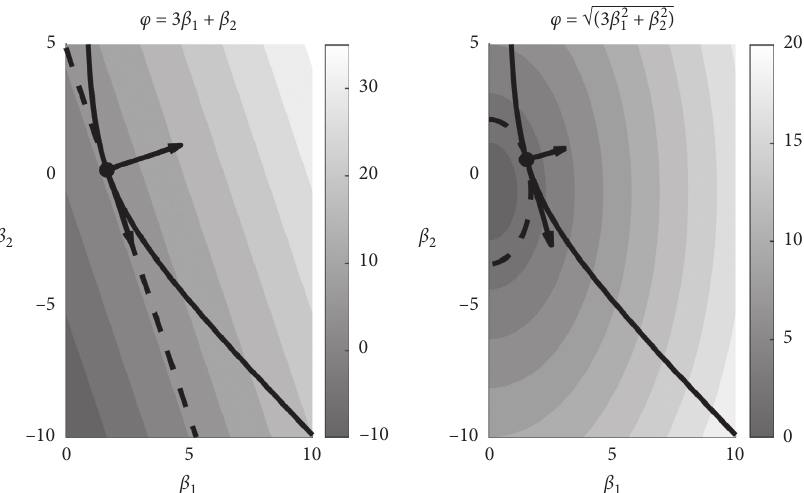
􏽱 ������� + β + β 2 (b). The gradient of φ and the tangent of : φ � 3 β (a); φ � 3 β 2 2 1 2 1 2